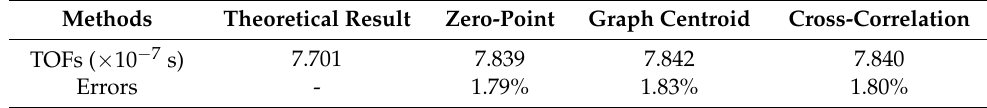
Table 2. TOFs determined by different methods.